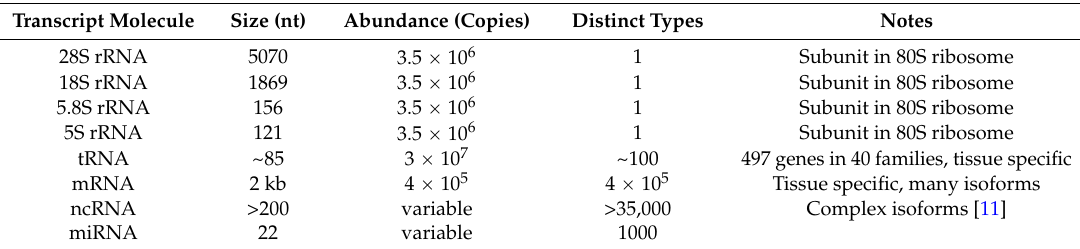
Table 1. Gross properties of typical Human Transcriptome.